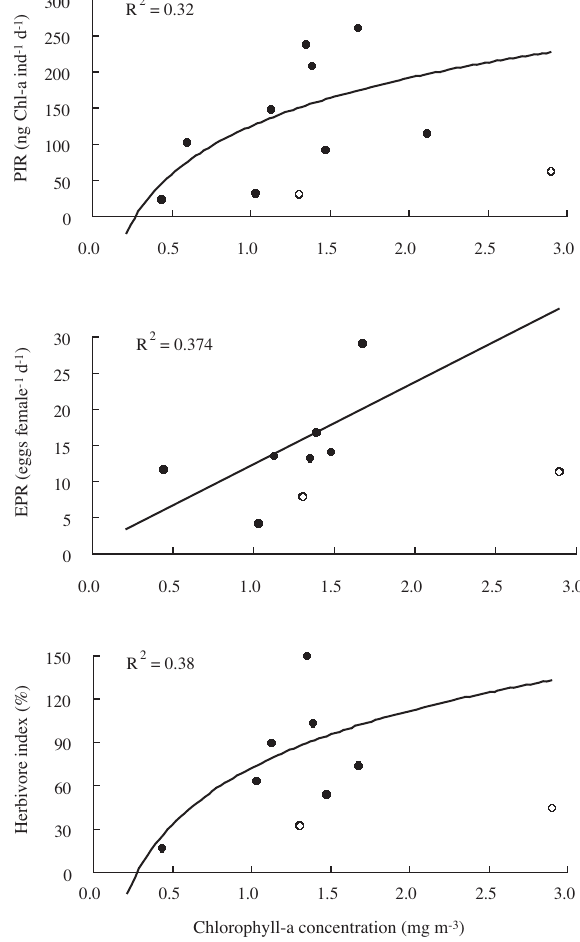
F IG 3. – Relationship between chlorophyll- a concentration and (from top) pigment ingestion rate, egg production rate, herbivore index of C. sinicus at each station. (Regression line based on only fill dots representing stations diatoms prevailed, two circles represents the two stations dinoflagellates